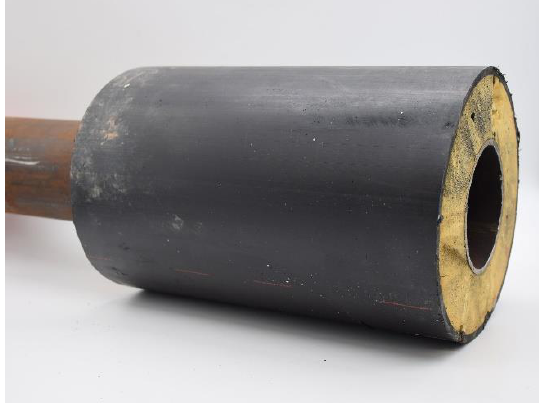
Figure 10. Photograph of the industrial insulated pipe sample.